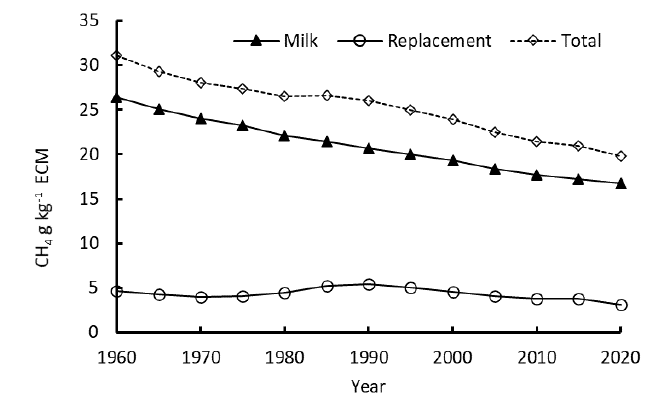
Fig. 4. Development of CH